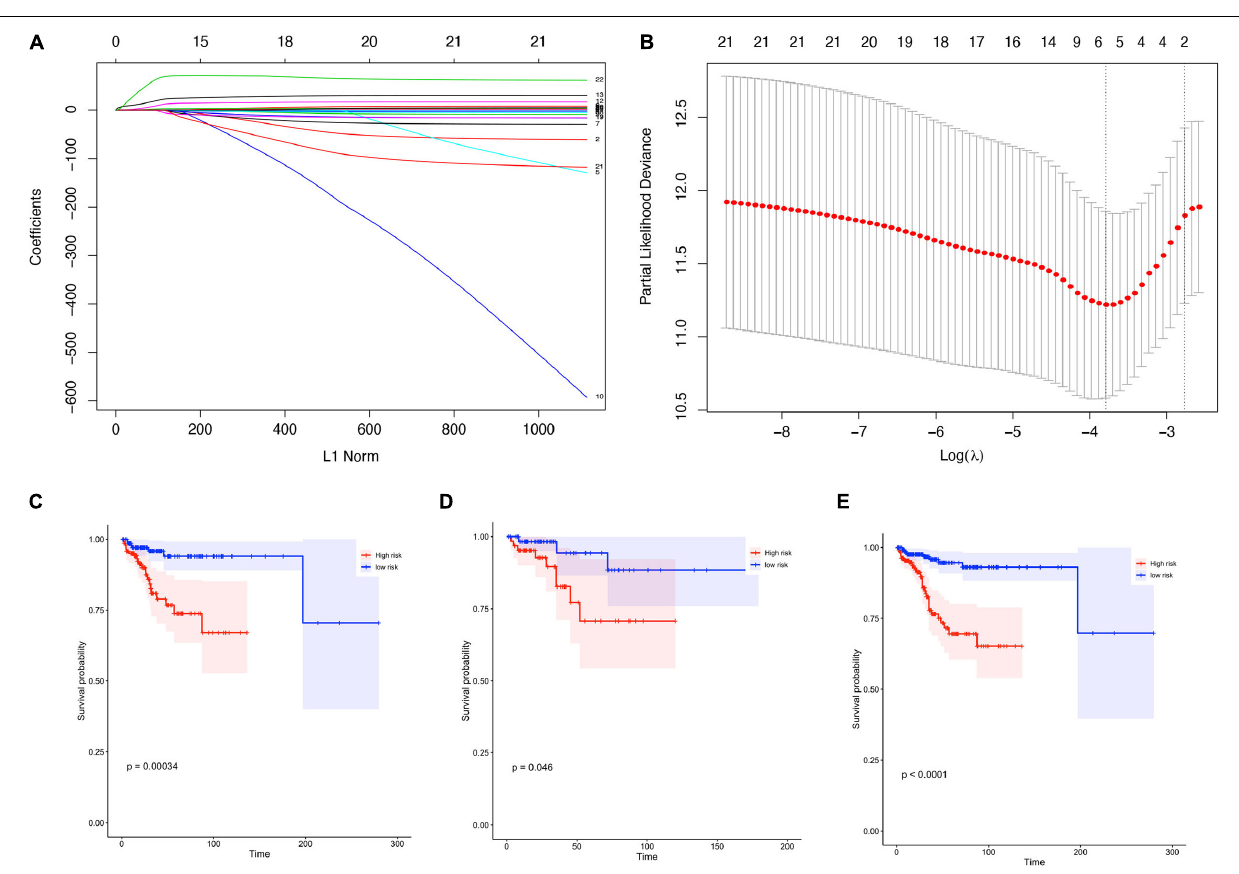
FIGURE 4 | Construction of prognostic signature in patients with gynecological malignant tumors. (A) Least absolute shrinkage and selection operator (LASSO) coefficient profiles of the fractions of 22 immune cell types. (B) Tenfold cross-validation for tuning parameter selection in the LASSO model. (C–E) Kaplan-Meier curves for survival in the training cohorts (C) , validation cohort (D) , entire cohort (E)